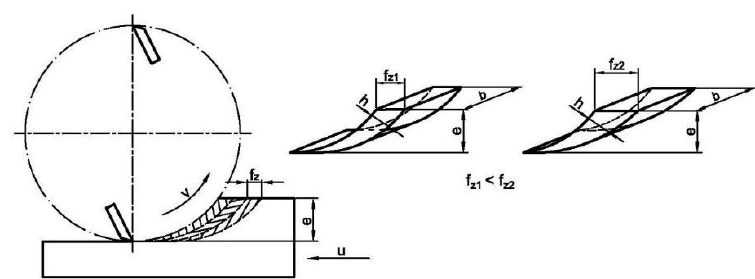
Figure 5. Particles resulting from milling, its different thickness when the feed per tooth is different f z . (h - nominal thickness of removed layer, e – depth of cut, b – thickness of sample) .